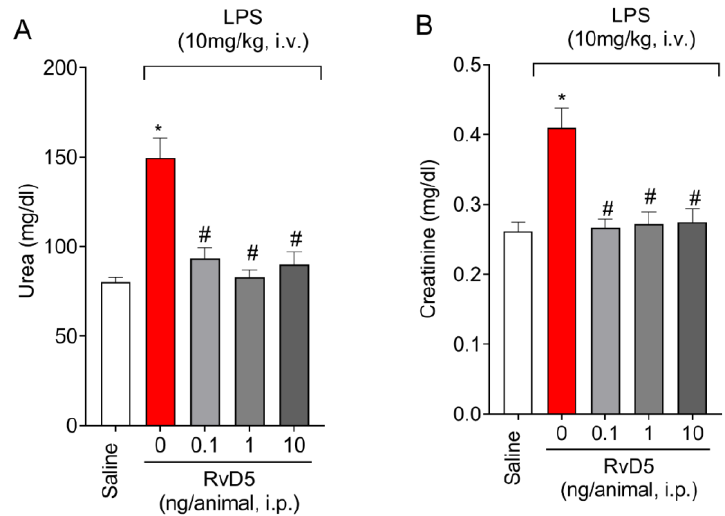
Figure 1. RvD5 decreases endotoxemia-triggered renal injury. The plasma levels of urea ( A ) and creatinine ( B ) were quantitated. Results are presented as mean ± SEM (standard error of the mean) of six animals per group and are representative of two replicates. (* p < 0.05 vs. saline, # p < 0.05 vs. LPS 10 mg/kg; one-way ANOVA followed by Tukey’s post-test).